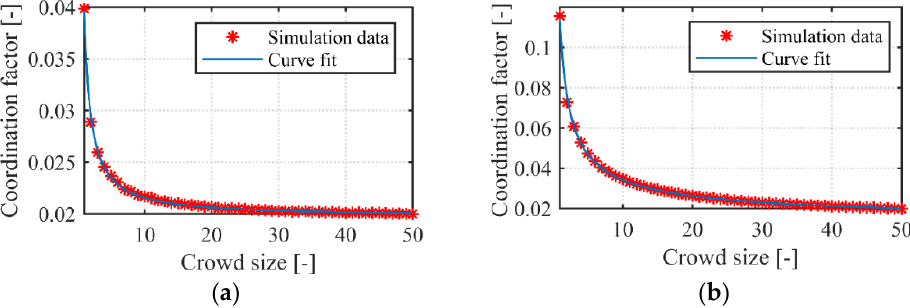
Figure 7. Conversion model for the coordination factor. ( a ) Model for the first harmonic, ( b ) Model for the second harmonic.